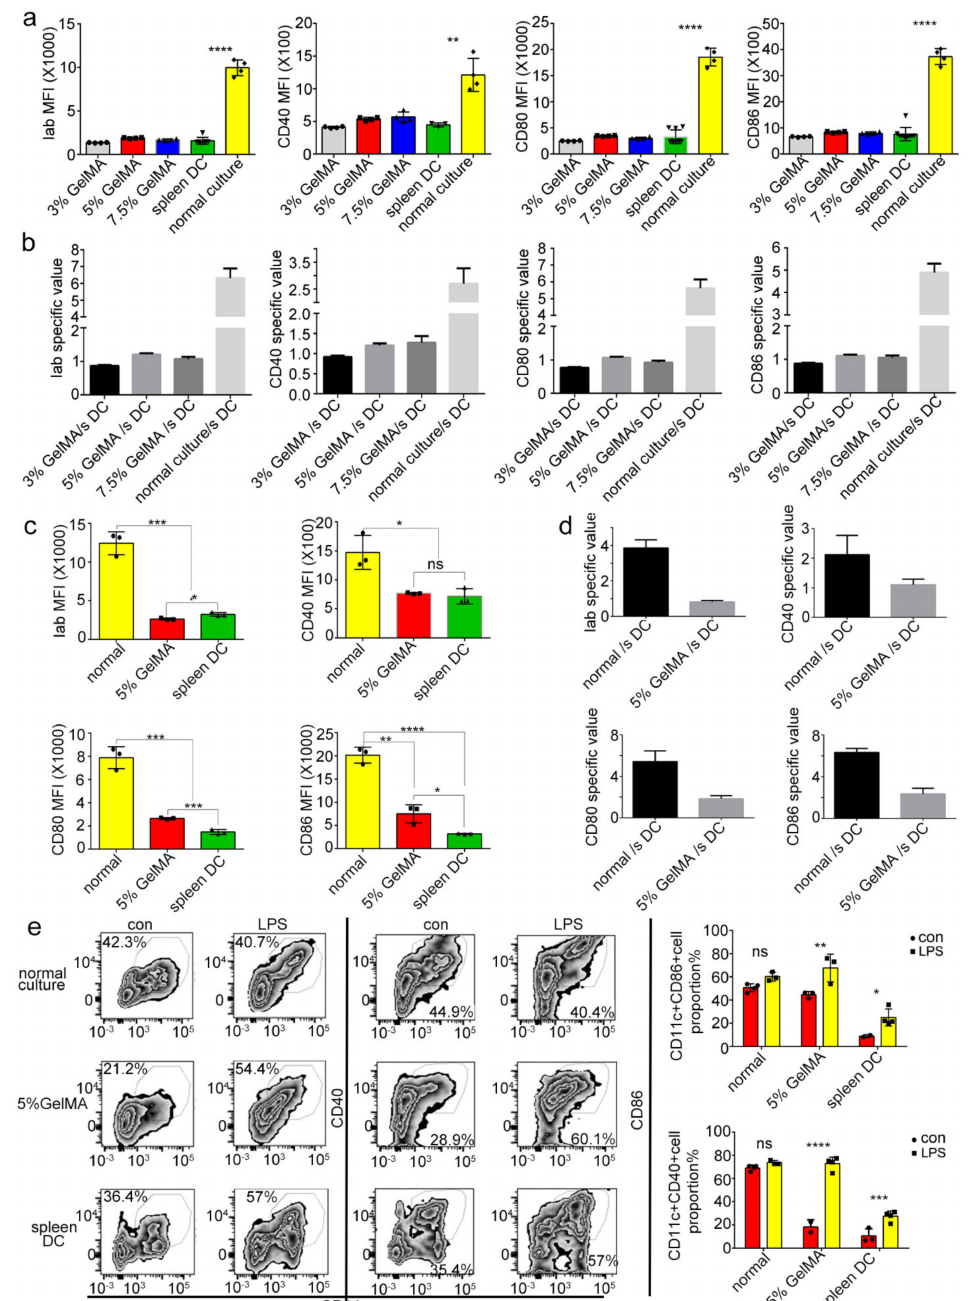
Figure 6. BMDCs cultured on 5% GelMA-30 were closer to the spleen DCs on phenotype and function in vivo. ( a , c ) BMDCs were collected from different culture systems, respectively. Then, the spleen DCs were collected by MACS to make the comparison for the expression of the costimulatory molecule with the application of FACS. ( b , d ) The costimulatory molecule specific values were obtained from the ratio of the MFI data of BMDCs from different culture systems, respectively, to the data of the spleen DC group. “s DC” represents the spleen DC. ( e ) BMDCs and spleen DCs were stimulated by LPS (100 ng/mL) for 24 h. Then, the cells were bound with Iab, CD40, CD80 and CD86 and were analyzed and compared in FACS. These experiments were repeated twice with essentially the same results. In all experiments, each picture was collected as means ± SEM, data were analyzed with unpaired student’s t test or analysis variance (ANOVA) and multiple comparison, and * p < 0.05, ** p < 0.01, *** p < 0.001, **** p < 0.0001, ns: nonsignificant. Mean fluorescence intensity,